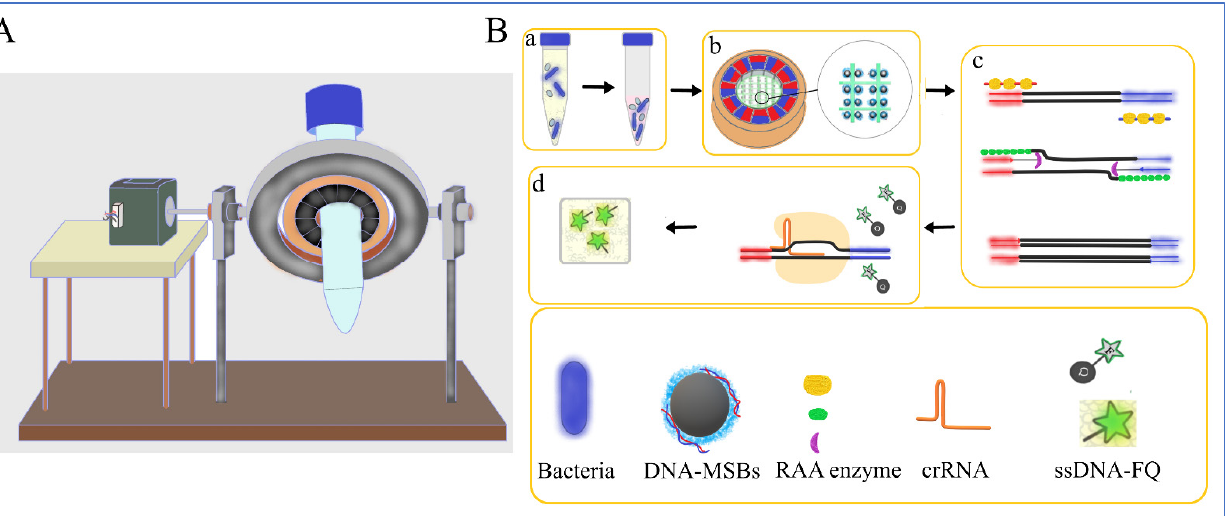
Figure 1. ( A ) The setup of the lab-on-a-tube biosensor; ( B ) the schematic of this lab-on-a-tube bio- sensor. ( a ) The yellow color and the pink color represent the milk sample and protease K with lysis bu ff er, respectively; ( b ) the relative position of MSBs and the iron wire ne tt ing; ( c ) the schematic diagram of RAA; ( d ) the schematic diagram of Cas12a-crRNA-target DNA complex active non-spe- ci fi c cleavage.